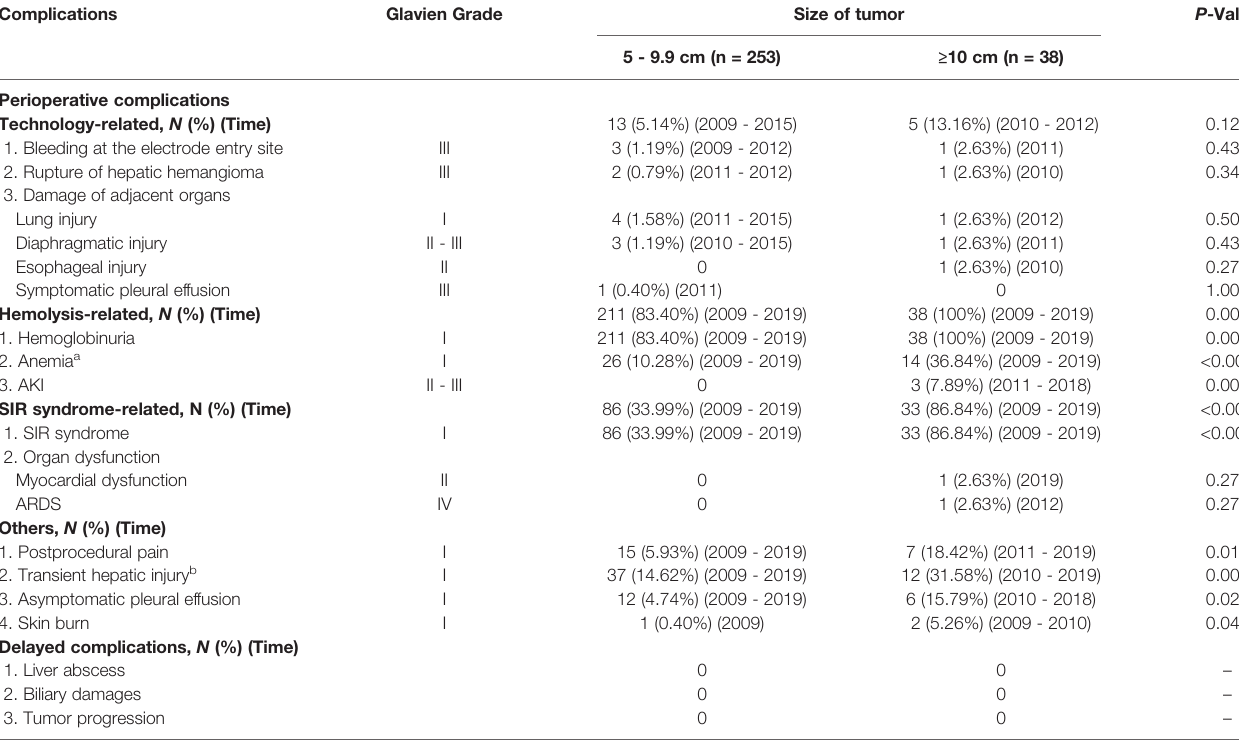
TABLE 4 | Complications after RFA for hepatic hemangiomas of 291